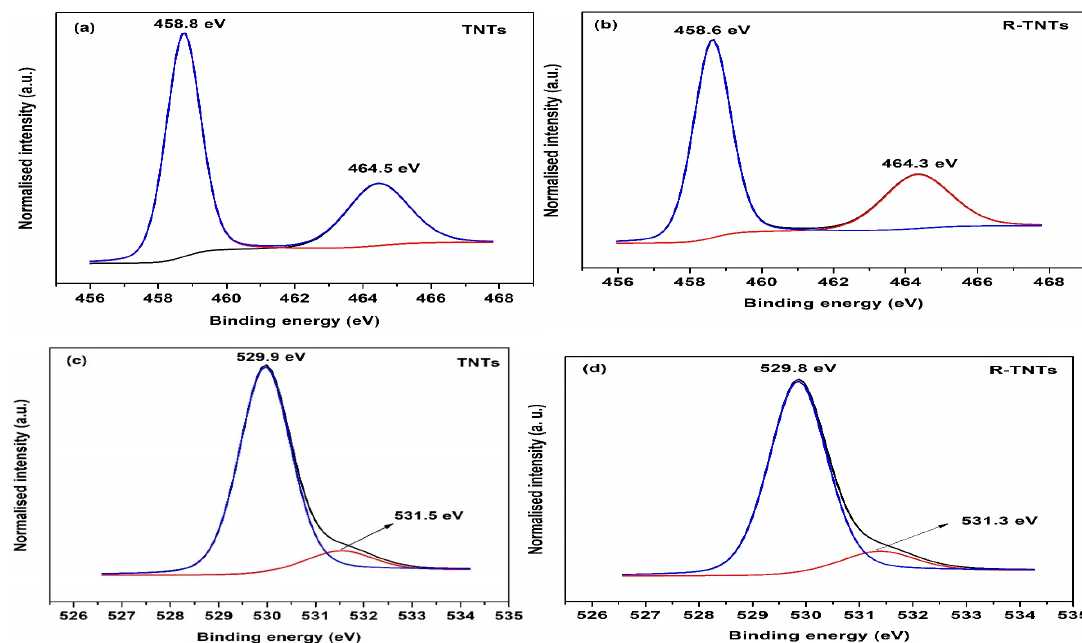
Figure 2. Ti 2p XPS spectra ( a ) TNTs, ( b ) R-TNTs and O 1s XPS spectra, ( c ) TNTs and ( d ) R-TNTs.